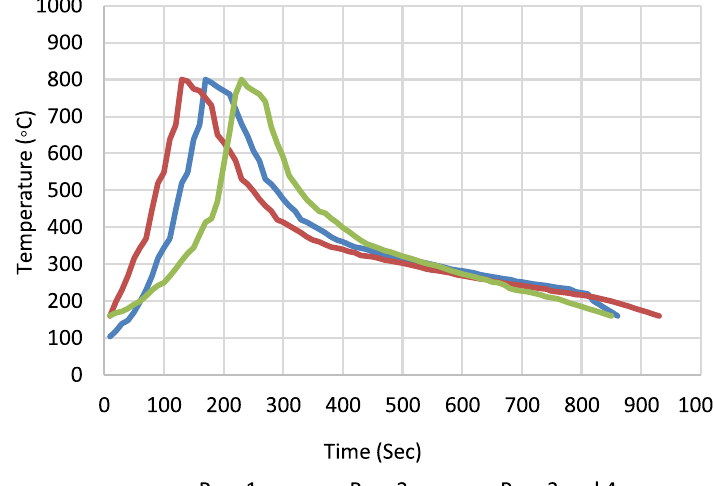
Fig. 5 Temperature cycle for single V using AWS A 5.9 ER307 without